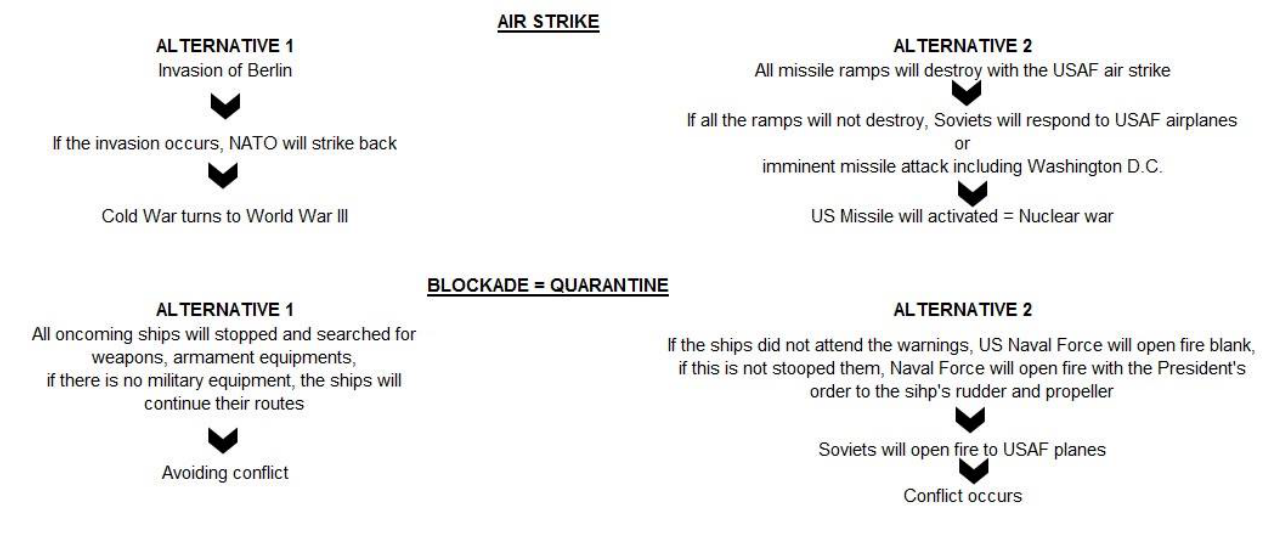
Figure 12 Implications of alternative solution proposals by President Kennedy It is seen that both of the alternatives calculated in the quarantine application are realized respectively. Two of the original six Soviet ships stopped and turned back, one ship disappeared from radar and was found a day later when it was about to break through the blockade and was stopped by blank fire. In the film, it is seen that the missile chests on the Russian ship were shot in close-up to create impact in the film. The real photo is framed from a higher angle with the plane shot. Figure 13 and 14 includes film and real